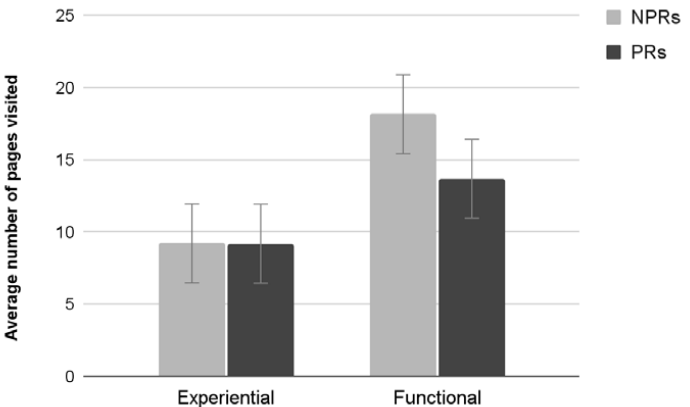
Figure 12. Average number of pages visited by Experience (NPRs vs. PRs) and Test (Experiential vs. Functional). Error bars denote 0.95 confidence intervals.